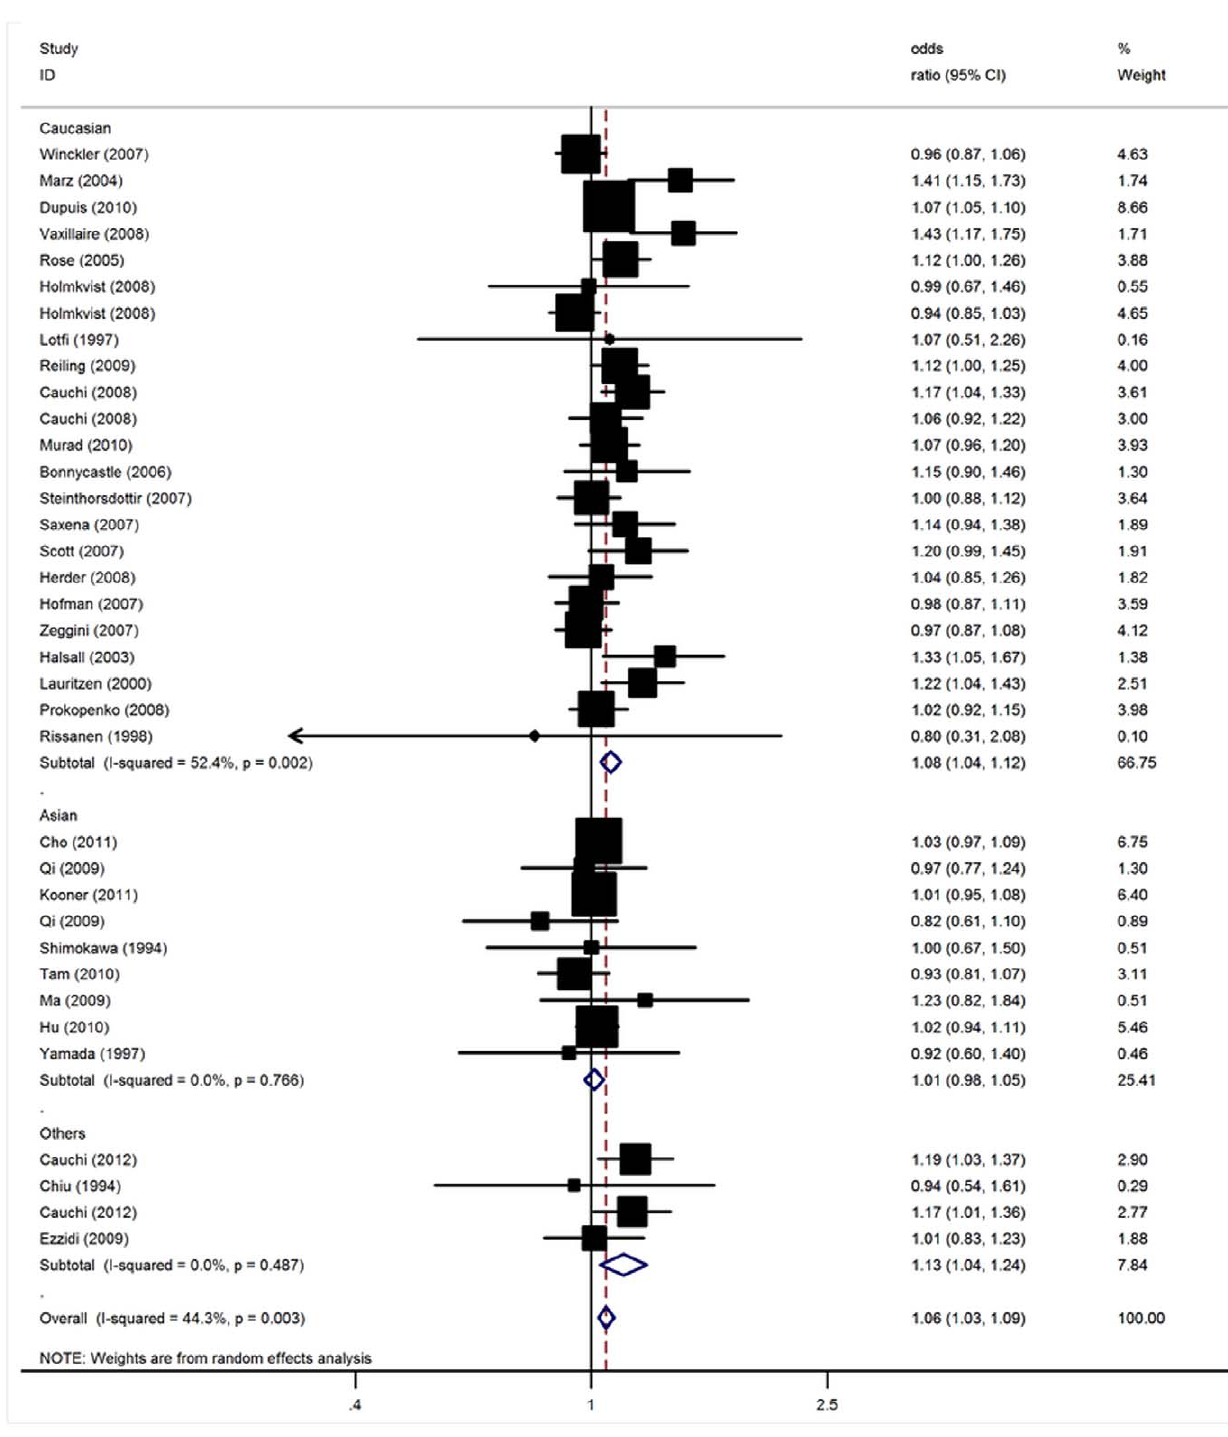
Figure 1. Forest plot for the overall association between the GCK 2 30G . A polymorphism and type 2 diabetes risk.